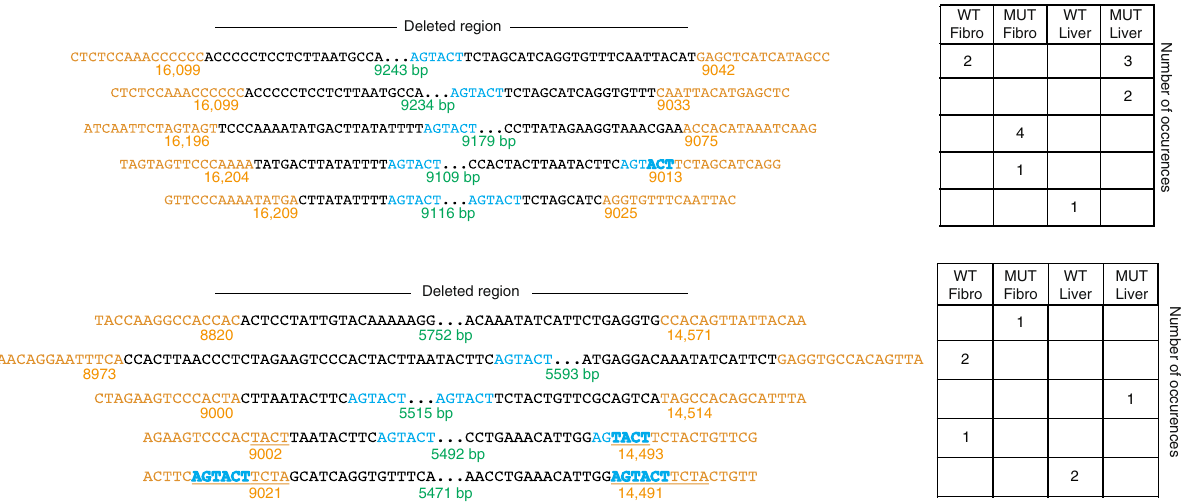
Fig. 5 Sequence analyses of mtDNA deletion breakpoints. PCR ampli fi cations of mtDNA deletion breakpoints from DNA of fi broblasts and liver infected with Ad-mito Sca I-HA (wild-type and mutator) were cloned in a TOPO TA plasmid (TA cloning) and sequenced using M13F and M13R primers. a Five representative sequences from the deletions [with O H ] and their frequency of detection in different samples. b Five representative sequences from the deletions [with O H and O L ] and their frequency of detection in different samples. Breakpoints are annotated as follows, orange text - mtDNA that is retained, black text -mtDNA which is deleted, blue text – Sca I sequence, green text - size of the deletion breakpoint, underlined text - micro or imperfect